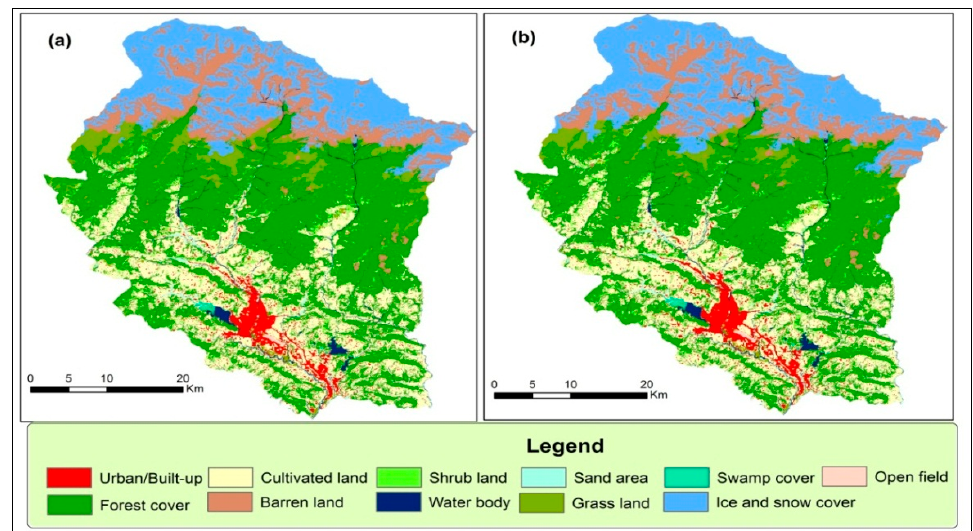
Figure 8. Simulated LULC maps for ( a ) 2025 and ( b ) 2035.